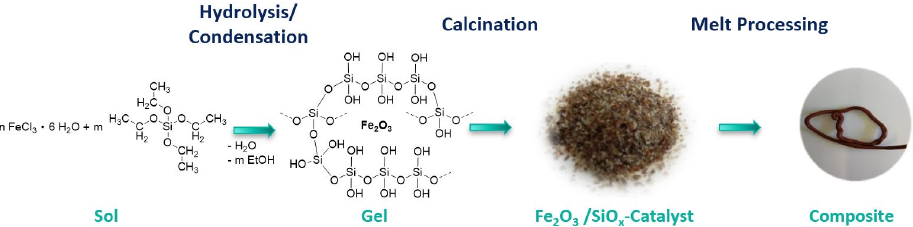
Scheme 1. Schematic presentation of the preparation of low-cost Fe 2 O 3 /SiO x Fenton catalysts by embedding the thermally treated sol–gel materials into a thermoplastic matrix resulting in compo- sites.